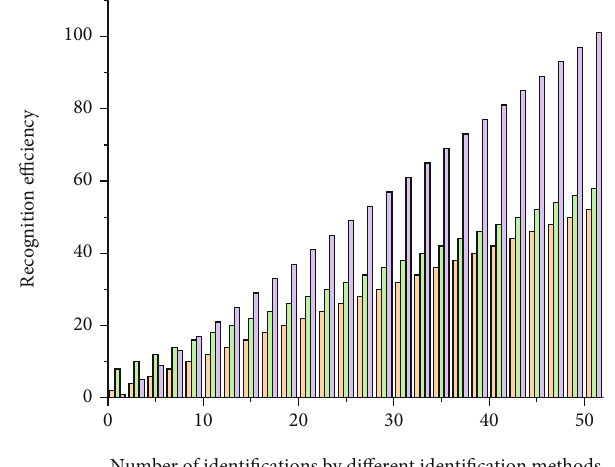
Figure 5: Comparison of experimental